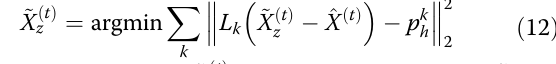
algorithm 39 . The corresponding high- fi delity